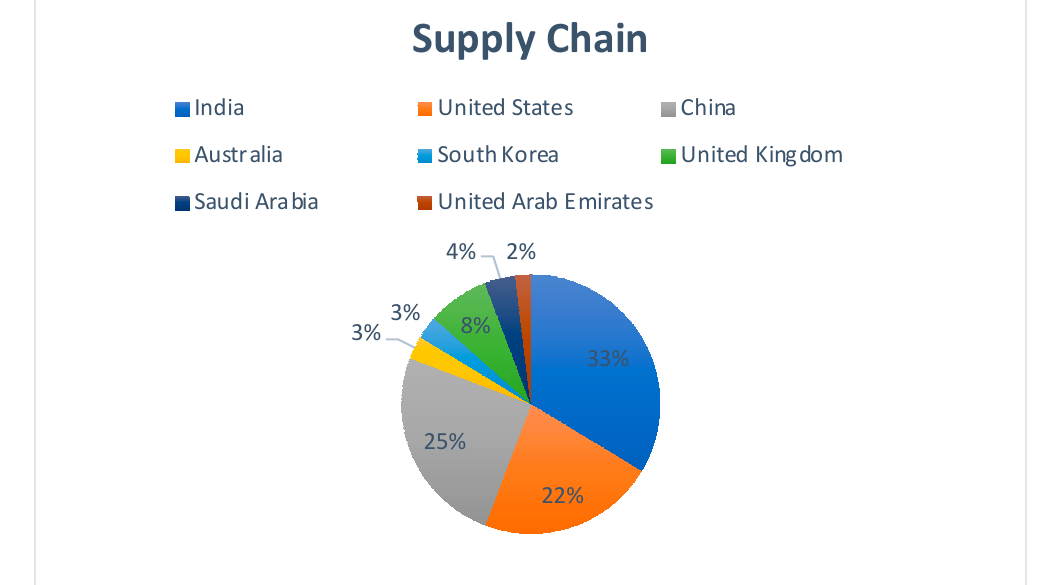
Figure 4. Region-specific publication distribution for Blockchain–Cloud and Supply Chain.